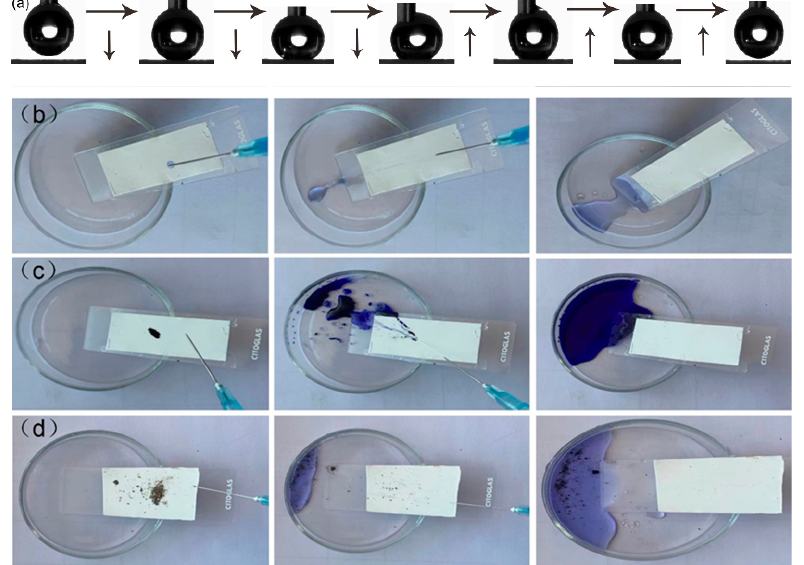
Figure 8. Self–cleaning ability of DP8–1.5 fiber membrane. ( a ) Water droplet drop experiment. ( b ) Water rebounds on the surface of an ultra–hydrophobic surface. ( c ) Methyl blue was removed by water droplets. ( d ) Sand grains were removed by water droplets.